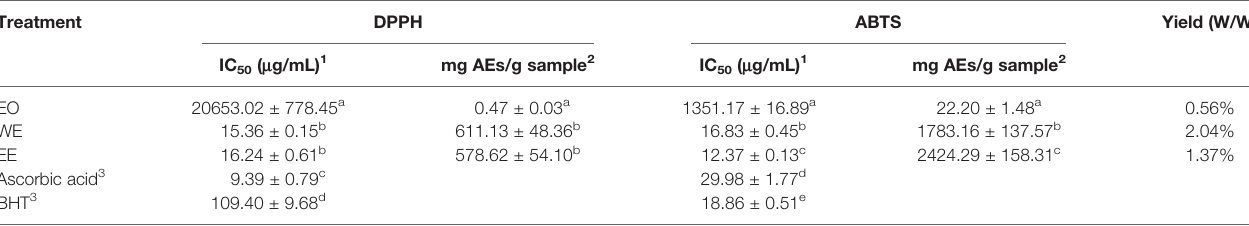
TABLE 2 | Antioxidant activity of the EO, WE and EE from H. fl avum rhizome.